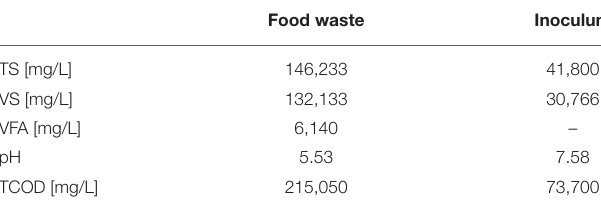
TABLE 1 | Characteristics of the food waste and the